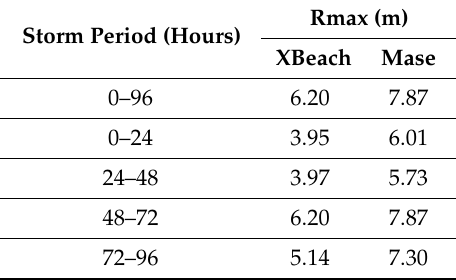
Figure 10. Maximum run-up time series predicted using XBeach and the Mase formulas for field storm conditions, and seawall freeboard level, considering a solid bottom in case II.SP. Table 5. Maximum wave run-up predicted using XBeach and Mase formulas for field storm conditions considering a solid bottom in case